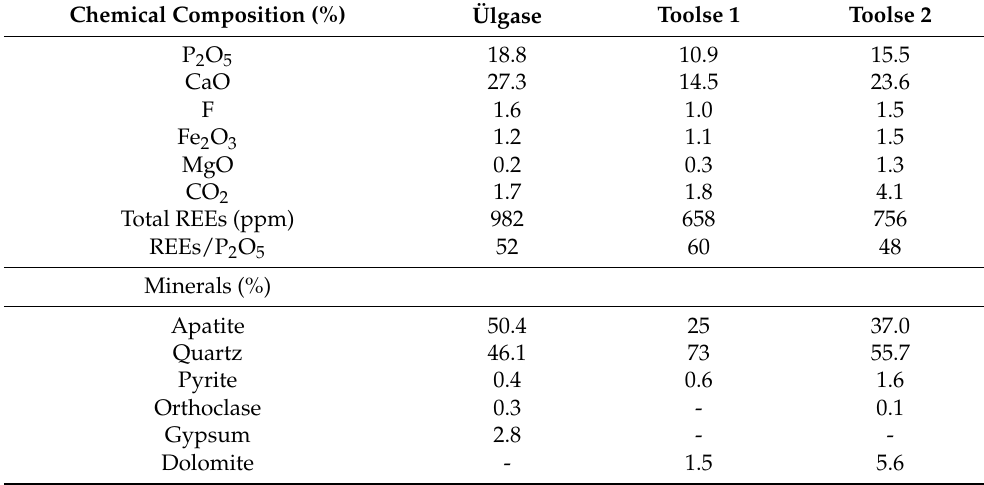
Table 1. Chemical and mineralogical composition of Estonian PR samples.